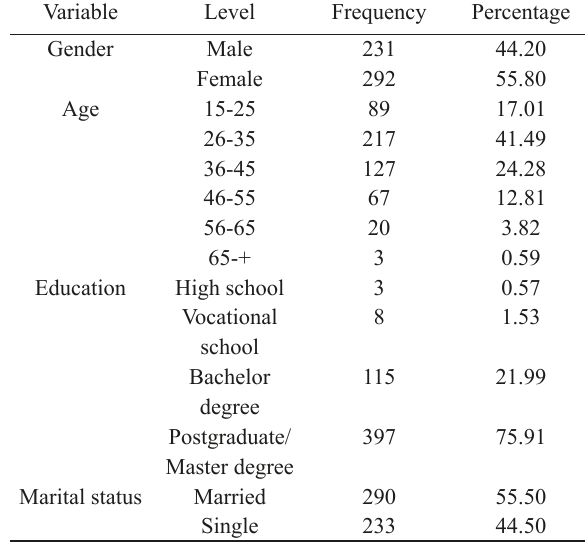
Table 3. Demographic Distributions of the